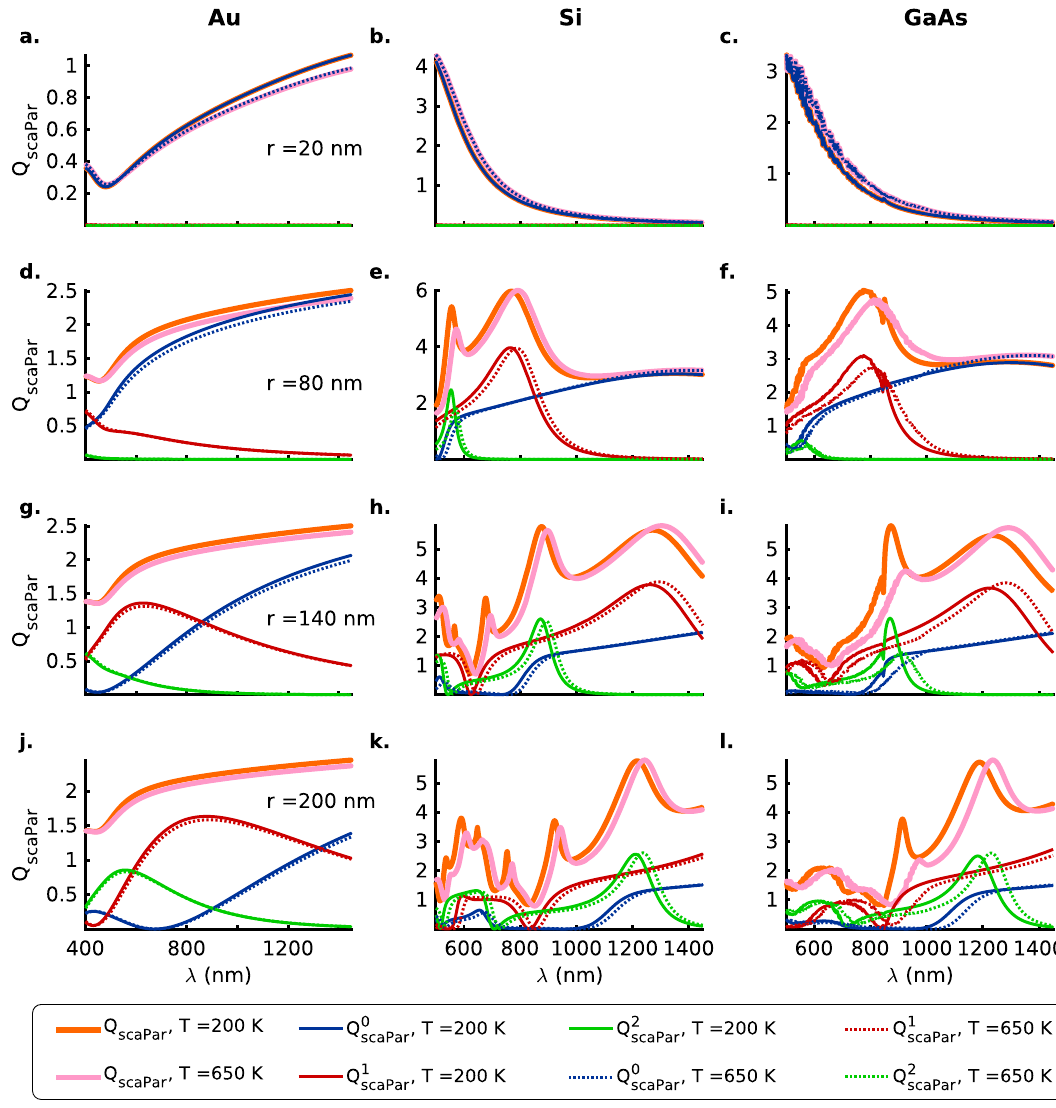
Figure 1. Mie scattering efficiency ( Q scaPar ) for the TM ( E ) polarization of the incident radiation with zeroth (cid:31) (blue), first (red) and second (green) order contributions as a function of the wavelength, (cid:31) , for ( a , d , g , j ) Au 20, 80, 140 and 200 nm , (Drude-Lorentz model), ( b , e , h , k ) Si and ( c , f , i , l ) GaAs nanoparticles of radii r = 200 (solid lines) and 650 (dotted lines) K . The thick orange and pink solid lines respectively, at temperatures T = 200 and 650 K , respectively. Here, the Mie represent the total scattering efficiencies, Q scaPar , at temperatures T = computations for the nanowires of different sizes take into account their thermal expansion, although the text labels indicate the values for nanowire radii at 200 K . Also see Tables S1–S3 a in the Supporting Information for a summary of the spectral positions of the resonances, the contributing orders to the scattering resonances and the numeric values of the scattering efficiencies for the TM ( E ) (cid:31)